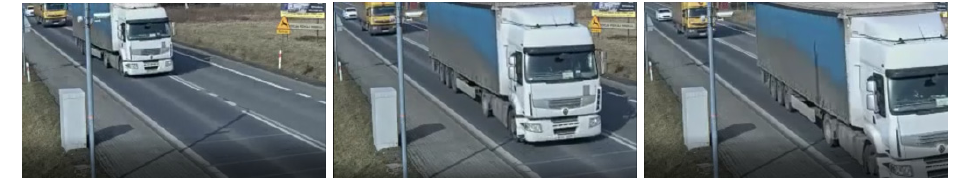
Table 12. Results for runs with a change of